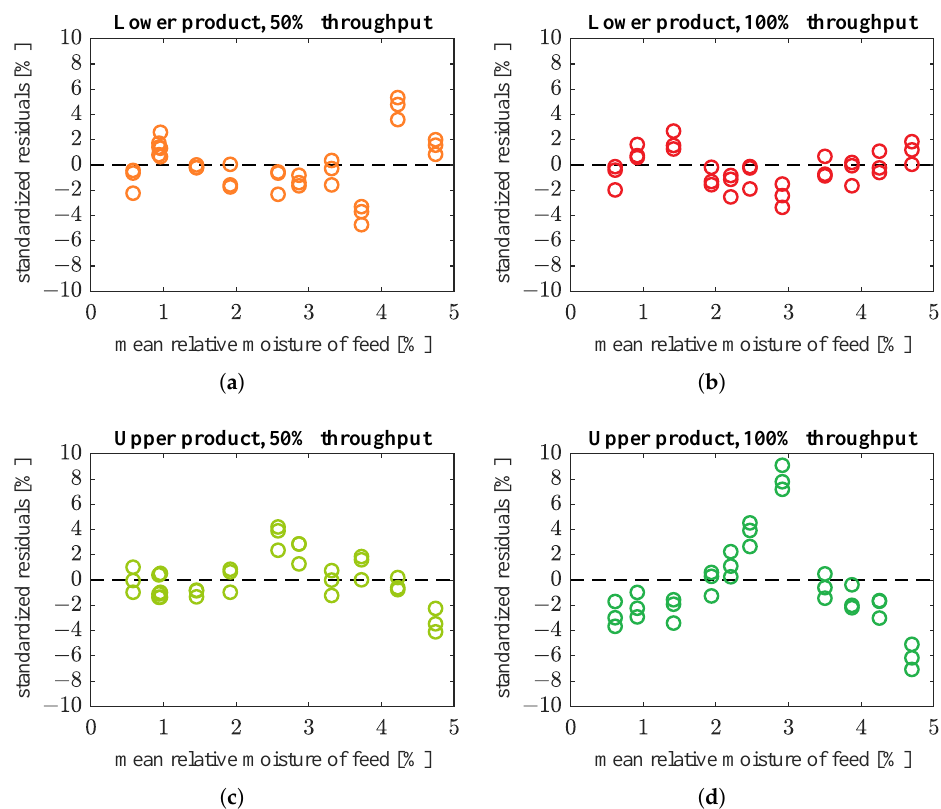
Figure 9. Residual plots for straight line models from Figure 8: ( a ) lower product, 50% of nominal throughput; ( b ) lower product, 100% of nominal throughput; ( c ) upper product, 50% of nominal throughput; ( d ) upper product, 100% of nominal